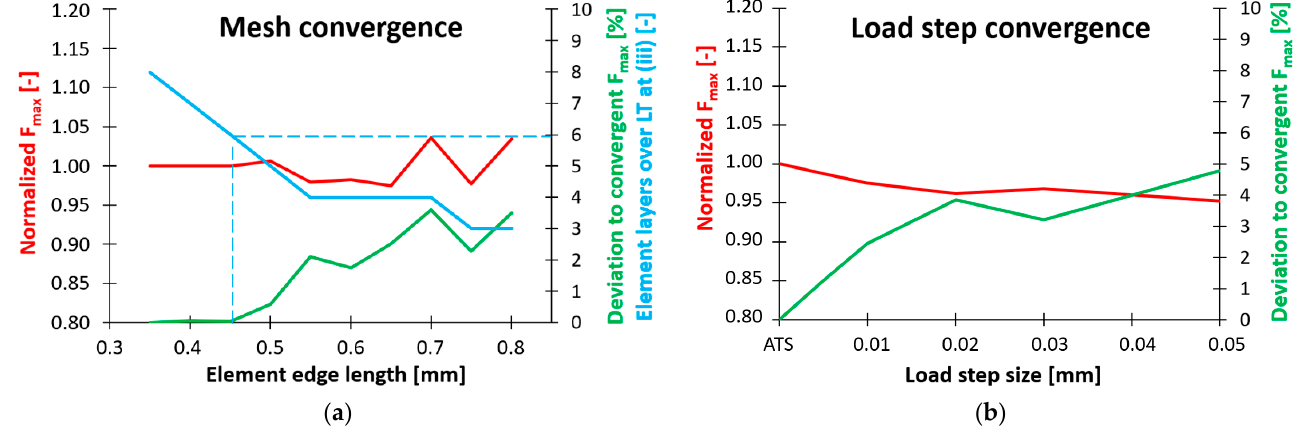
Figure 11. Convergence studies. ( a ) Influence of element edge length; ( b ) Influence of load step